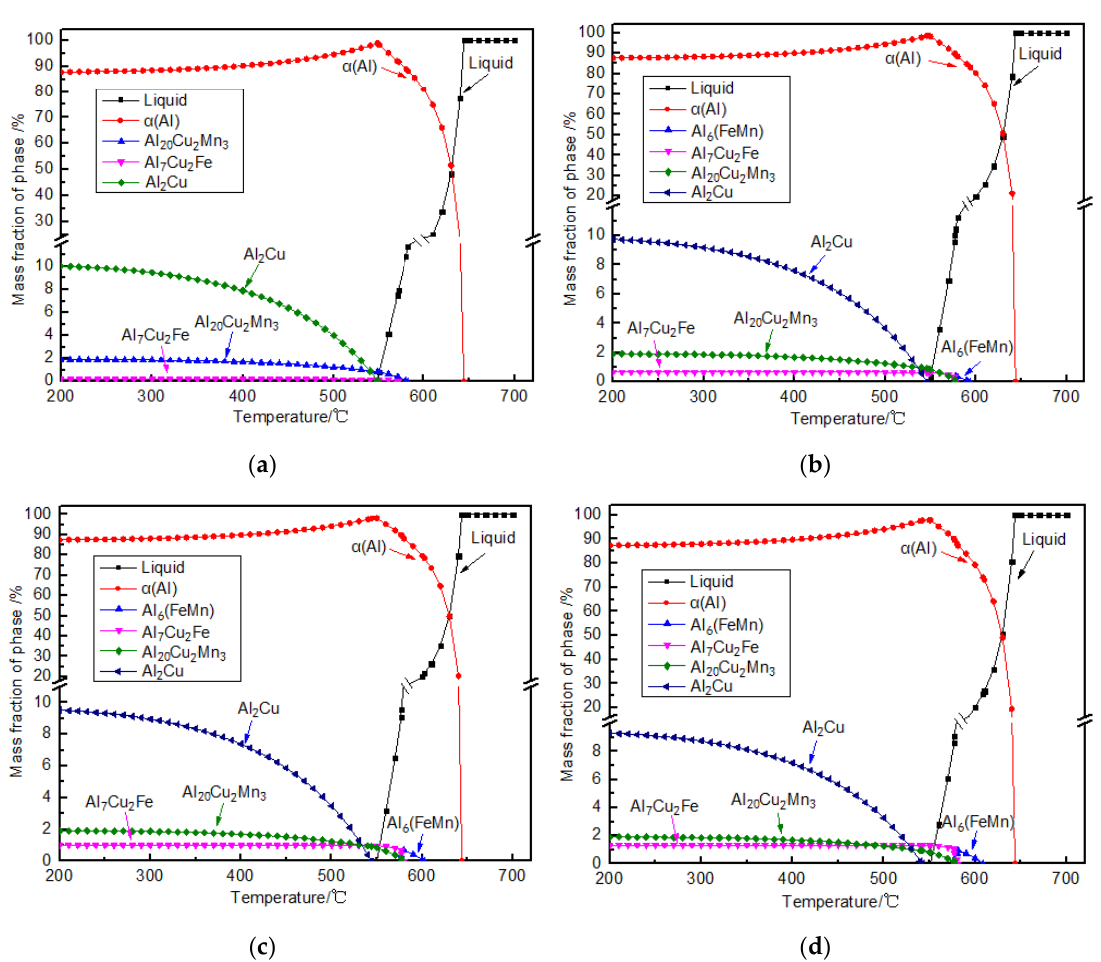
Figure 11. Phase fraction vs. temperature curves of 2219 Al–Cu alloy with different Fe contents calculated by the software JMatPro 7: (a) 0.03 wt.%; ( b ) 0.1 wt.%; ( c ) 0.15 wt.%; and ( d ) 0.2 wt.%.